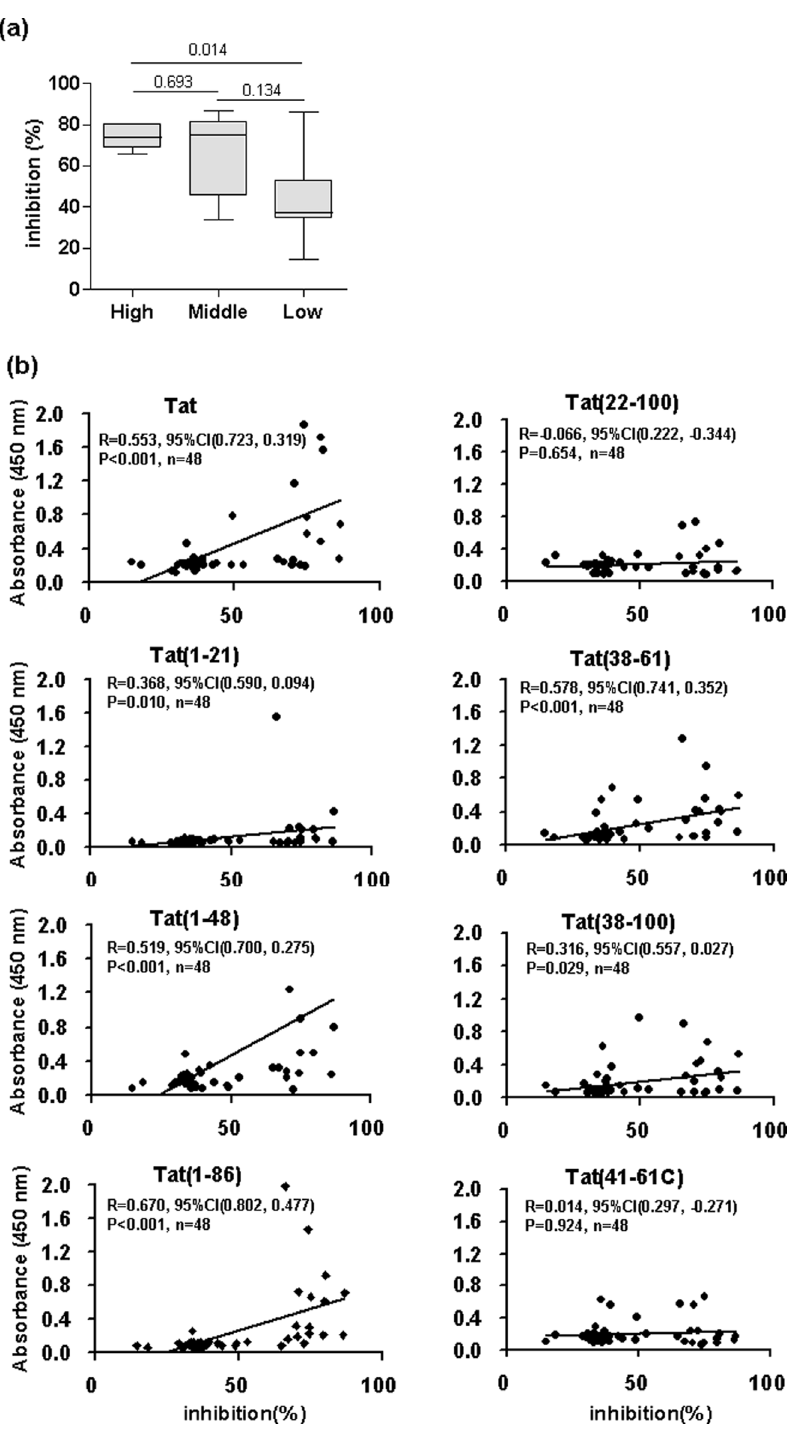
Figure 5. The correlations of antibody reactivity against eight antigens and percent inhibition of transactivation. (a) Antibody- mediated neutralization of exogenous recombinant full-length Tat. Percent inhibition at 48 h was plotted on the y-axis with samples classified by Tat- antibody levels on the x-axis (High—samples with strong reactivity to full-length Tat with OD values above 1.0; Middle—samples with moderate reactivity to full-length Tat with OD values between 0.3–1.0; Low—samples with weak reactivity to full-length Tat with OD values between 0.2–0.3). Statistical significance was tested using Wilcoxon non-parametric test. (b) A comparison of the correlations of antibody reactivity against full-length Tat or the analytic antigens and percent inhibition of transactivation. The correlation was assessed by Spearman correlation coefficient. Correlation coefficient values (R), p values and the samples size (n) are shown.